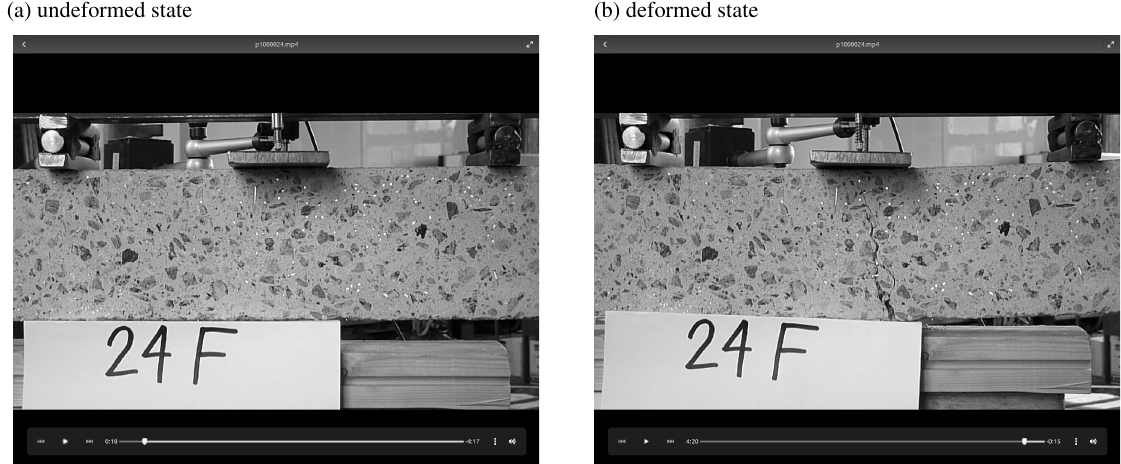
Fig. 5. Typical photos used for digital image correlation (undeformed and deformed state).